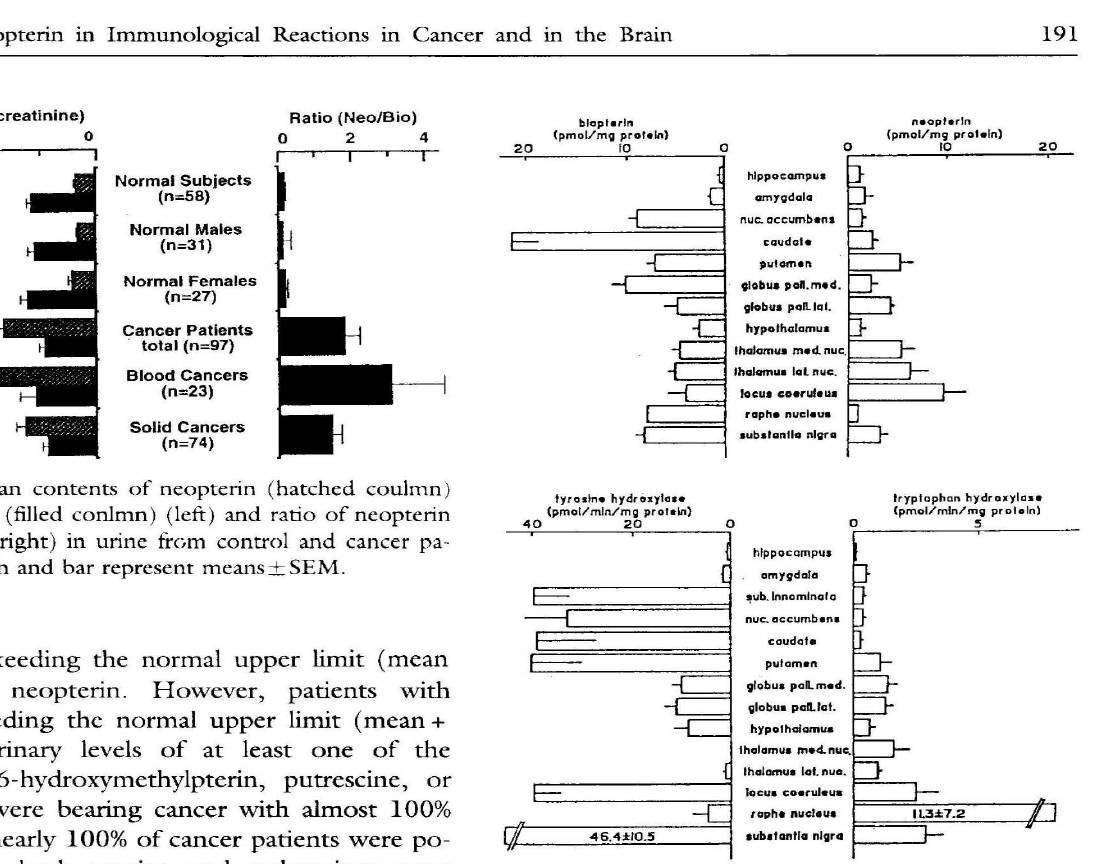
Figure 2. Mean contents of neopterin (upper right) and biopterin (upper left), and enzymatic activity of tyrosine hydroxylase (lower left) and tryptophan hydroxylase (lower right) in the normal human brains. Column and bar represent means ±